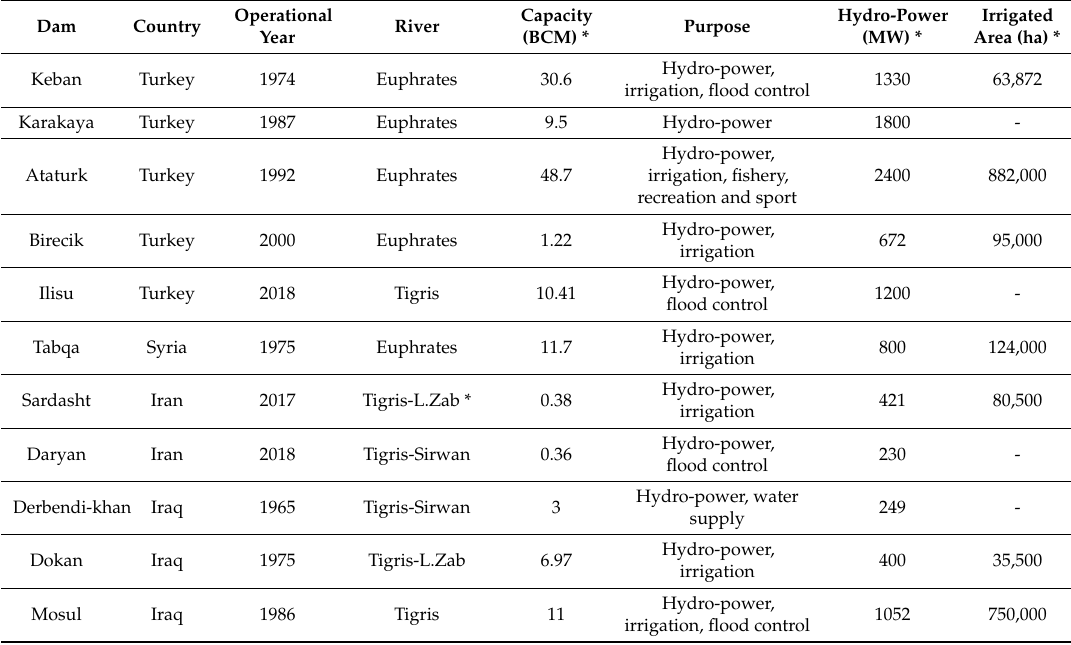
Table 3. The dams built on the Tigris and Euphrates rivers in riparian countries, data sources